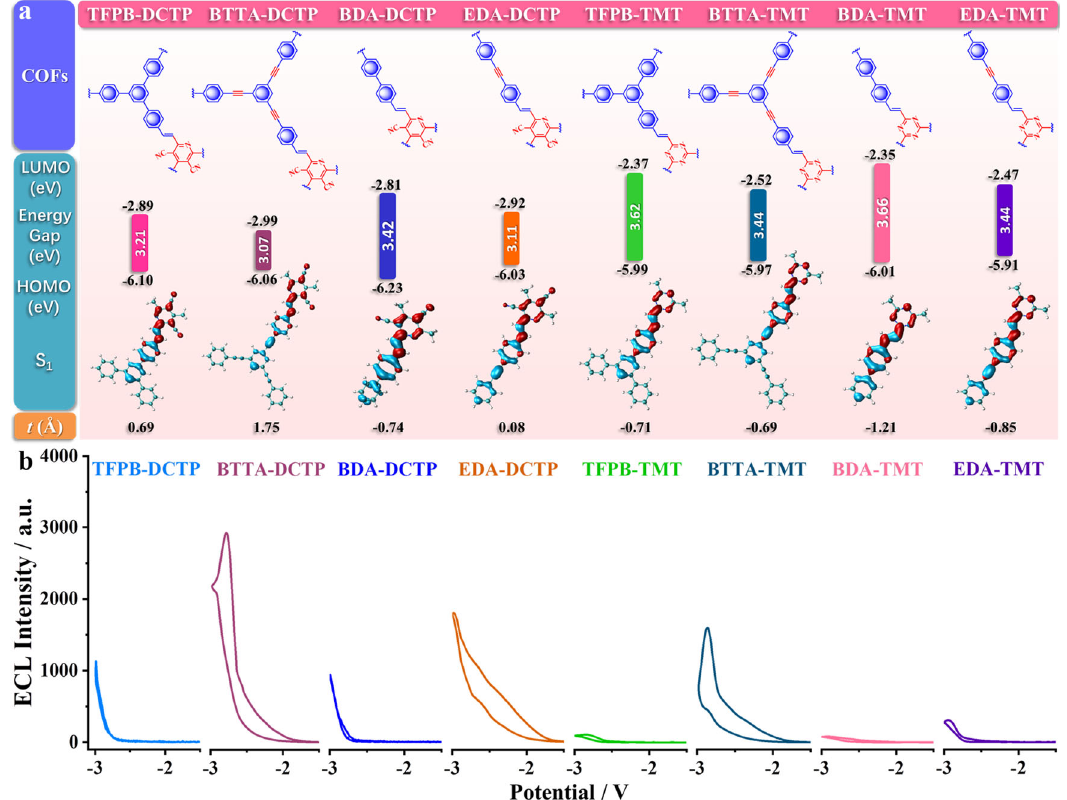
Fig. 5 In fl uence of COFs ’ conjugation degree on ECL performance. a DFT calculations to the building blocks of COFs. The values of HOMOs, LUMOs, and calculated energy gaps and analysis for the distribution of the hole (blue) and electron (red) for S 1 are indicated. The t index is measured to evaluate the separation degree of hole and electron. b Comparison of ECL intensities of COFs in 0.1 M PBS with 0.1 M KCl between 0 V and − 3.0 V, pH 7.5, PMT: 800 V, potential scan rate: 100 mV s − 1